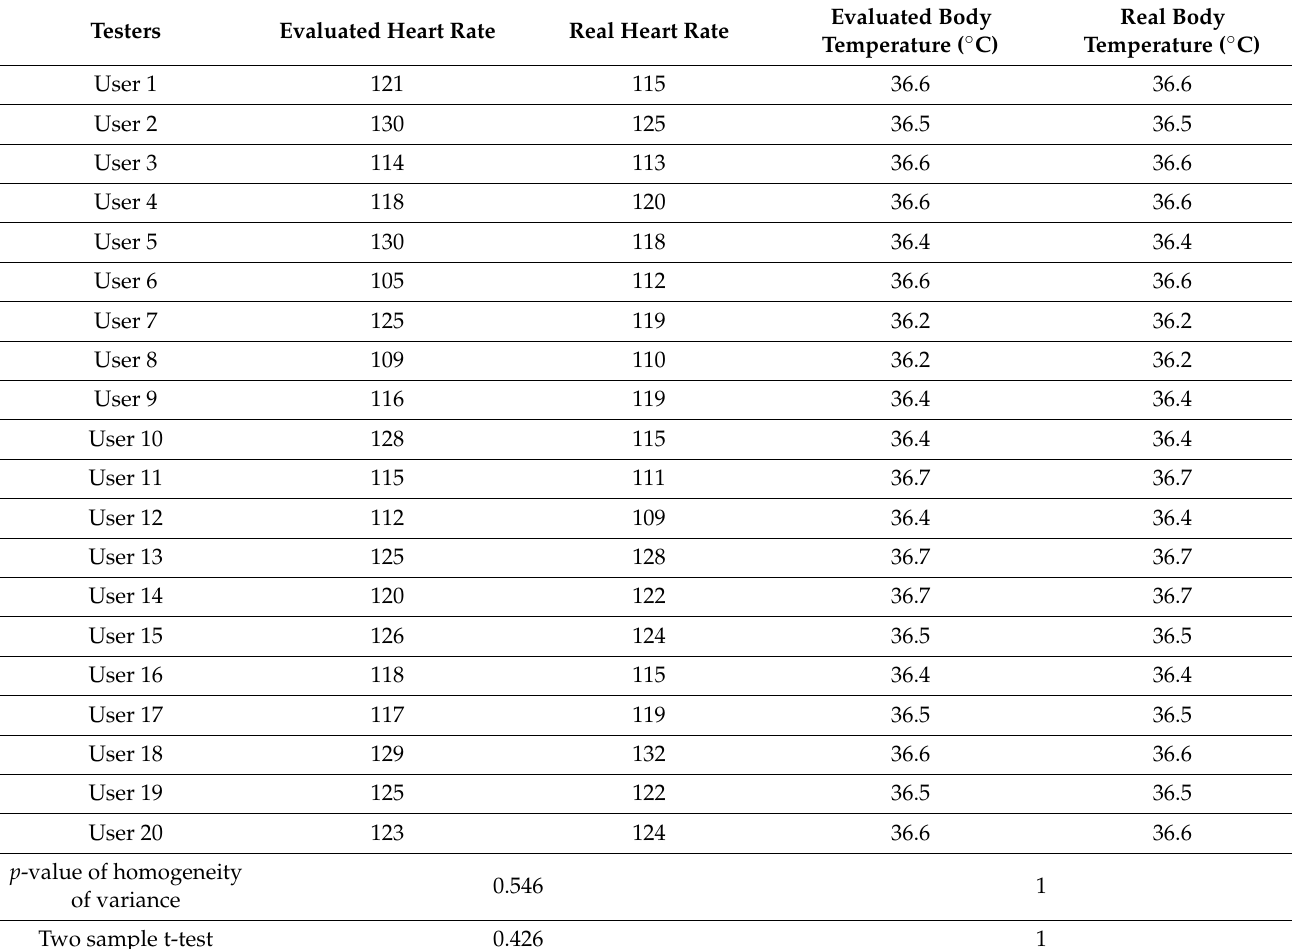
Table 7. Experiment results of 20